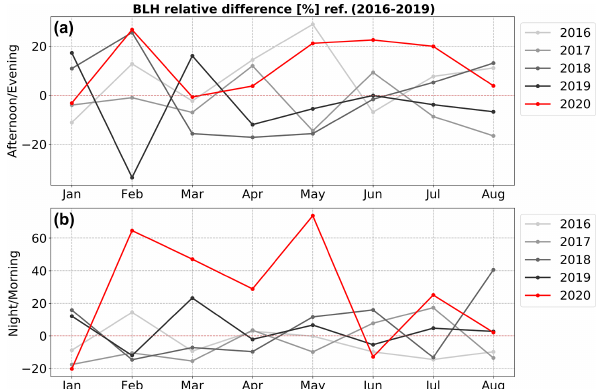
Figure 11. Monthly averaged boundary layer heights interpolated in space and time from the 3-hourly ECMWF operational fields on 1 ◦ resolution for afternoon–evening (a) and nighttime–morning (b) . Afternoon–evening is defined as 3h after sunrise until 2h before sunset, and nighttime–morning is defined as 2h before sunset until 3h after sunrise. The boundary layer heights are expressed as a per- centage difference from the mean height calculated over the period of 2016–2019.